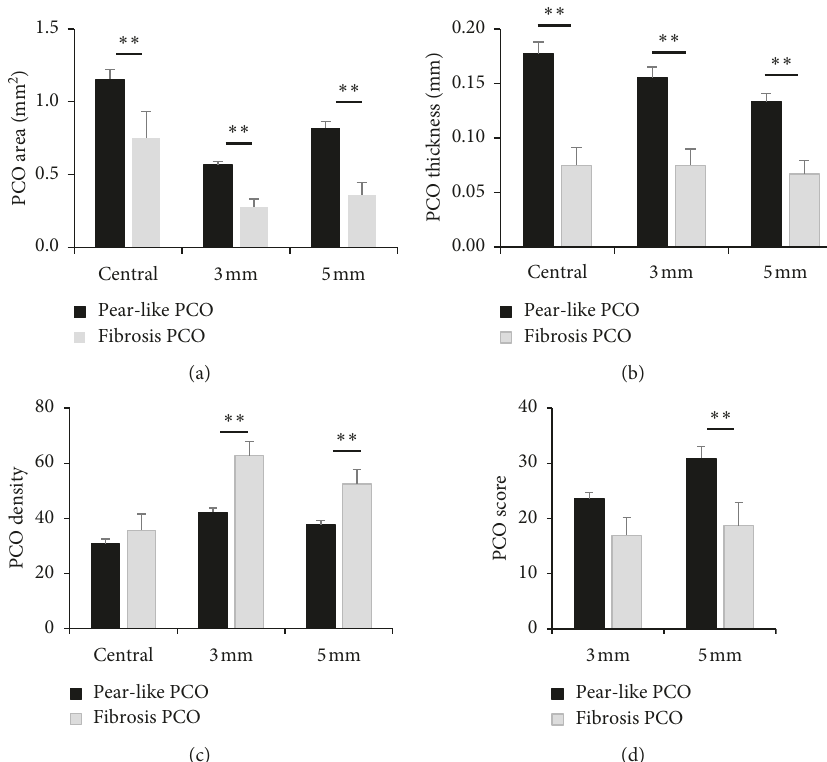
Figure 6: Comparison between pear-type and fibrosis-type PCO. (a) Area of the two types of PCO; central refers to the full area of the IOL- posterior capsular space. 3mm and 5mm refer to the area of the 3mm and 5mm diameter range of the IOL optic region. (b) Thickness of the two types of PCO; central refers to the central point of the full IOL optic region and 3mm and 5mm refer to the point at the 3 mm and 5mm diameter range of the IOL optic region. (c) Density of the two types of PCO; central refers to the full area of the IOL-posterior capsular space. 3mm and 5mm refer to the area of the 3mm and 5 mm diameter range of the IOL optic region. (d) Objective score of the two types of PCO. A Mann–Whitney U test was used to compare the differences. ∗∗ p < 0 .